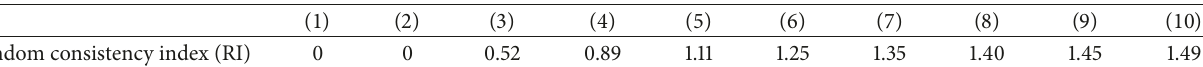
Figure 3: Structure of criteria for the heritage assessment of the assets. Table 3: Average random consistency index (RI) [11,